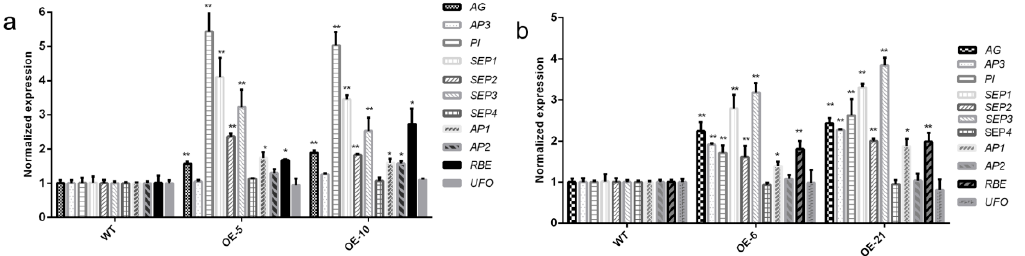
Figure 6. Effects of CpCZF1 and CpCZF2 overexpression on the transcript levels of regulatory genes related to stamen identity specification. Expression of stamen identity-related genes in the WT and the CpCZF1-OE ( a ) and CpCZF2-OE ( b ) flowers. The RNA was extracted from flowers at Stages 0–6 from the inflorescences of WT and transgenic Arabidopsis . Data were expressed relative to AtActin , which served as the internal control; the error bars represent the standard deviations per triplicate. The * and ** indicate a significant difference from WT at p < 0.05 and p < 0.01, respectively, as determined by the Student t